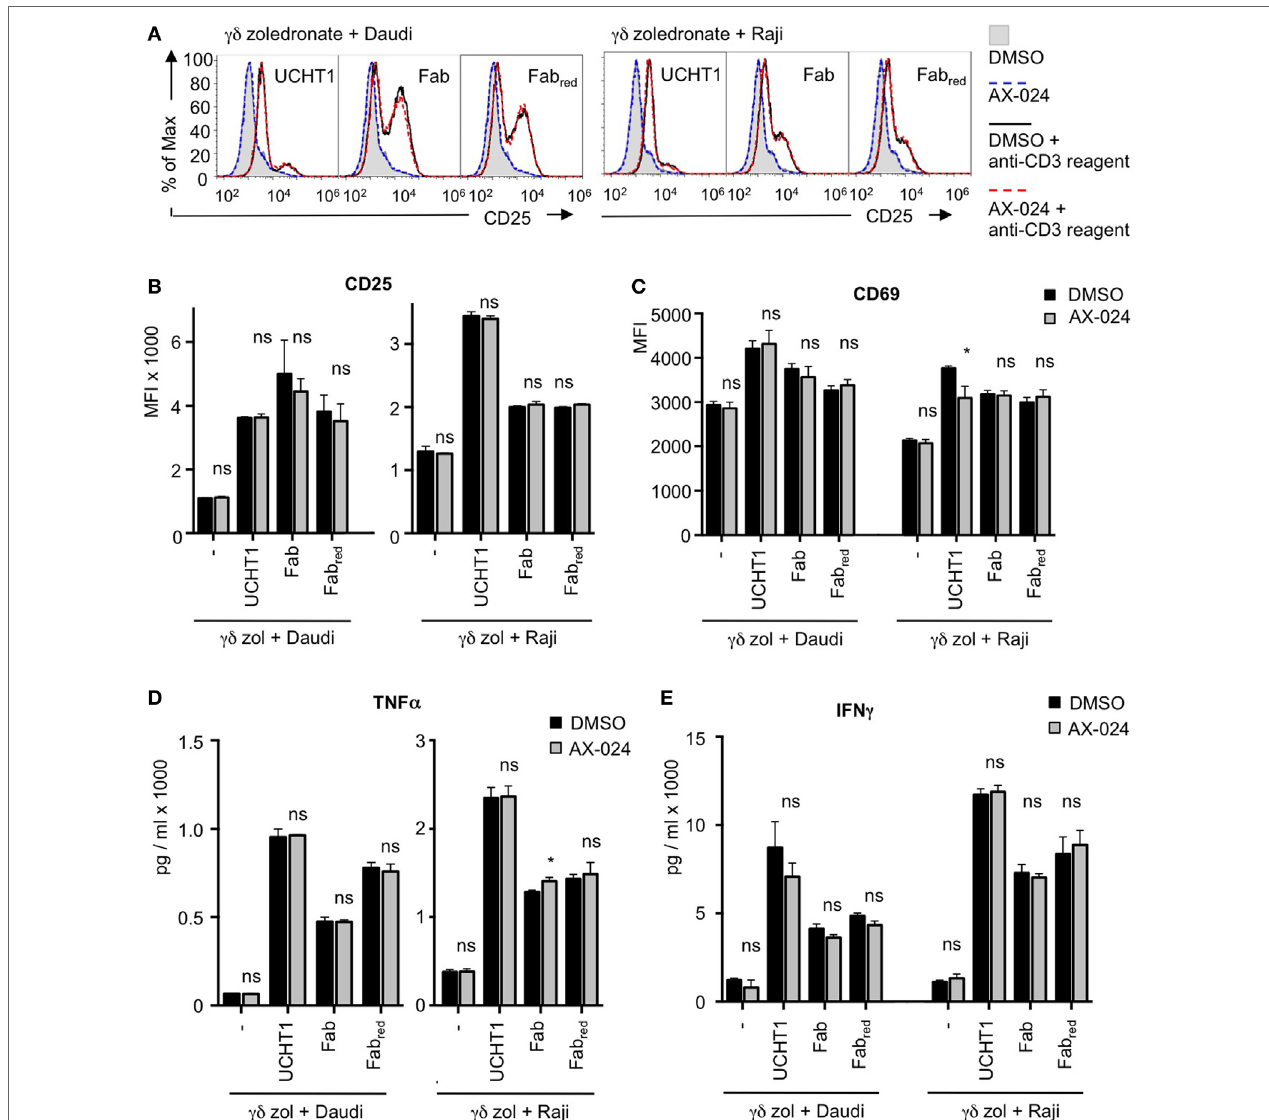
FigUre 7 | The up-regulation of activation markers and cytokines is independent of Nck recruitment to the γδ T cell antigen receptor (TCR). Daudi and Raji cells were incubated with zoledronate-expanded γδ T cells without ( − ) or with 5 µg/ml UCHT1, 3.33 µg/ml Fab, or 3.33 µg/ml Fab red . In addition, 10 nM AX-024 was included or not. The γδ T cell to target cell ratio was 12.5:1. The cells were co-cultured at 37°C and 5% CO 2 for 18 h. Subsequently, cells were either stained with anti-CD25 and anti- γ / δ TCR (a,B) or with anti-CD69 and anti- γ / δ TCR (c) antibodies. Fluorescence intensities were quantified by flow cytometry (a) and the mean fluorescence intensity is displayed (B,c) . Data represent mean ± SD of triplicates ( n = 3). Significance was determined by unpaired t -test, two-tailed between untreated samples and samples treated with AX-024. (D,e) The experiments were performed as in (a) . After co-culturing of the cells for 18 h, the supernatants were harvested. TNF α (D) and IFN γ (e) concentrations were quantified by enzyme linked immunosorbent